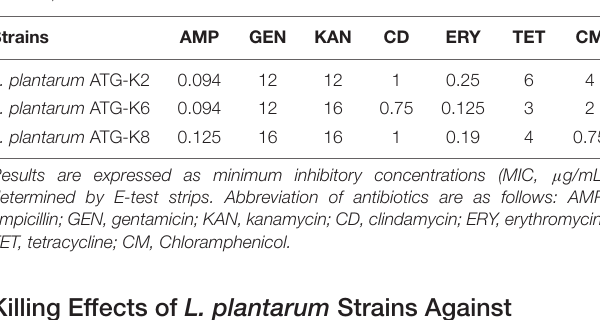
TABLE 2 | Antibiotic susceptibility of L. plantarum strains ATG-K2, ATG-K6, and